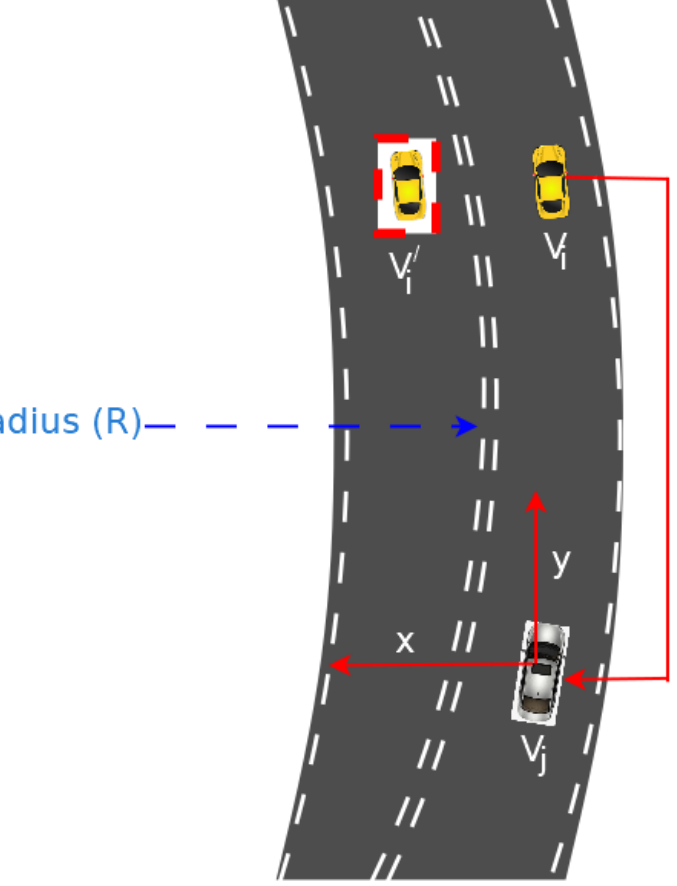
Figure 3. Path Deviation Attacker